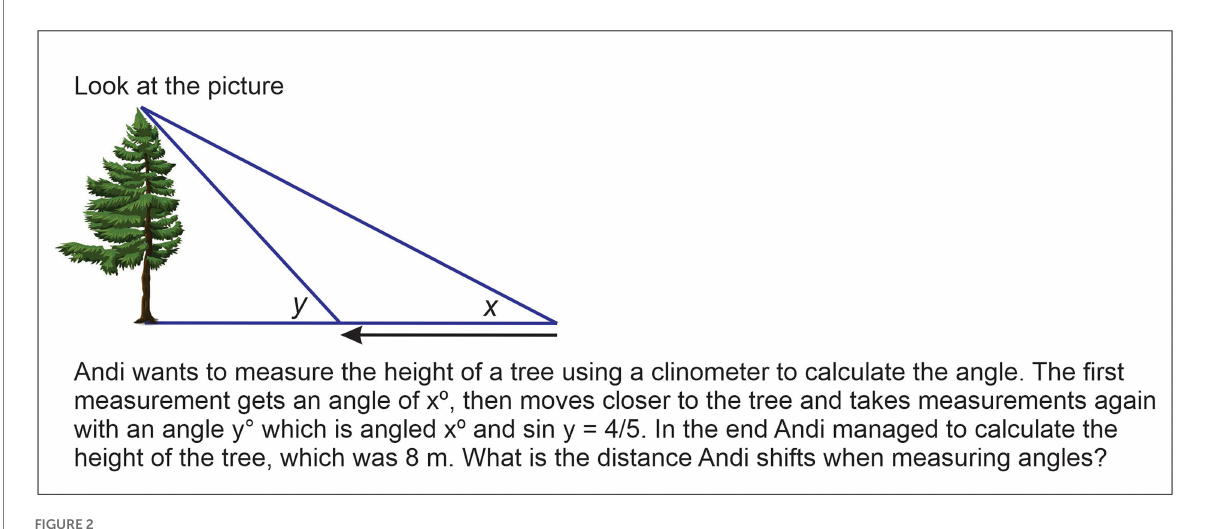
FIGURE 2 An example of a student’s mathematical critical thinking ability